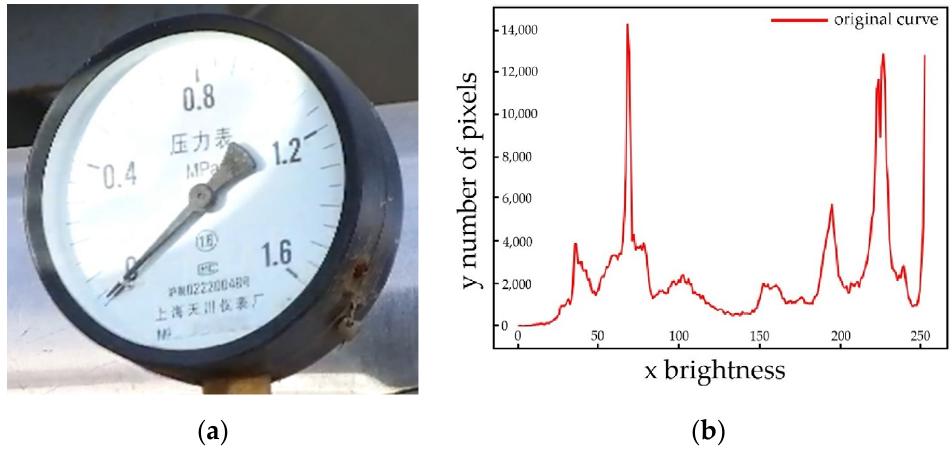
brighter the image is. The vertical axis represents the corresponding number of pixels, and the red polyline represents the brightness pixel distribution of the pointer meter image.